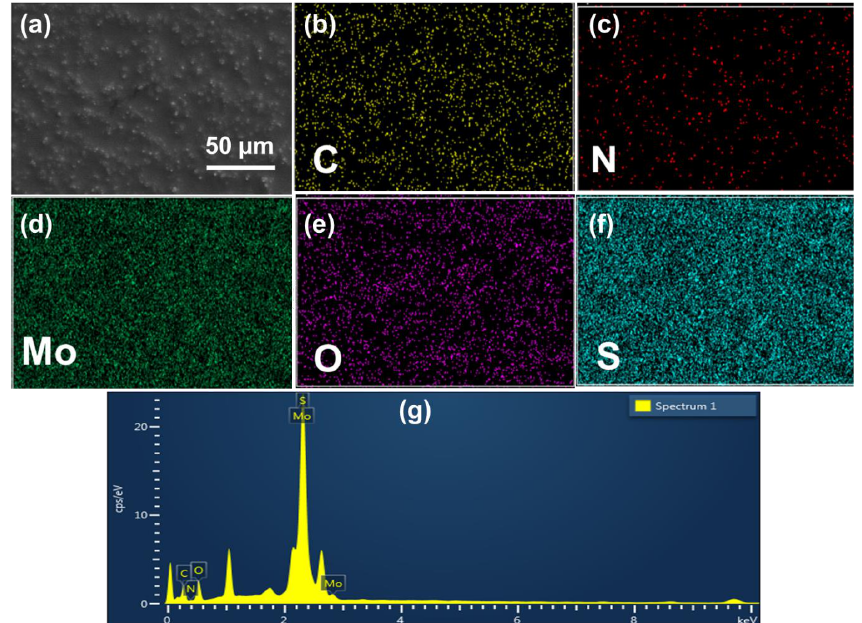
Figure 2. ( a ) SEM image of MoS 2 QDs and corresponding elemental mapping for ( b ) C, ( c ) N, ( d ) Mo, ( e ) O, and ( f ) S. ( g ) The EDX spectroscopy of the MoS 2 − QDs. The electrochemical characteristics of MoS 2 − QDs were performed by CV measure- ments using a 0.1 M PBS buffer solution having neutral pH (pH ~7.0) as electrolyte. The bare GCE and MoS 2 -QDs on GCE both revealed no oxidation peak in the absence of hy- drazine, as shown in Figure 3a. However, compared to the bare GCE, MoS 2 -QDs modified GCE exhibited an increment of ~4.5 folds higher anodic current to suggest the improved